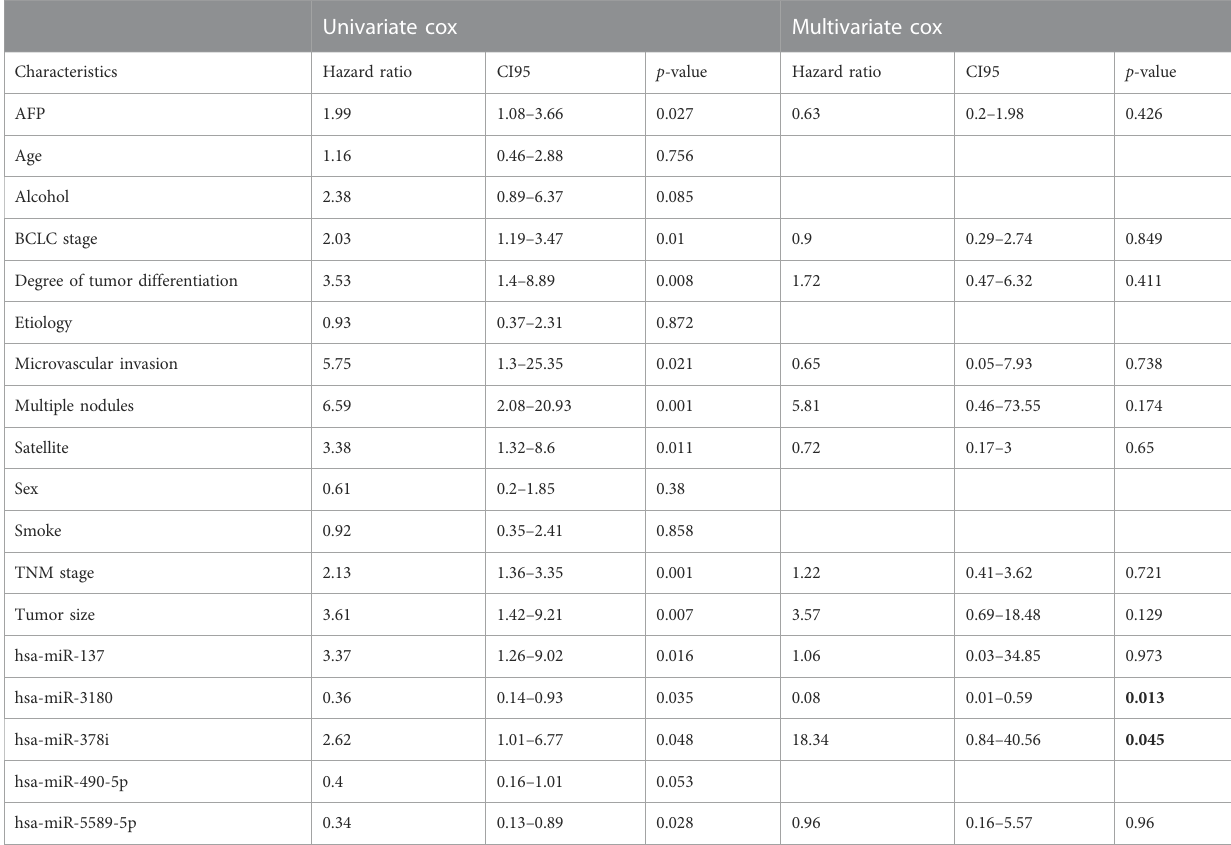
TABLE 1 Univariate and multivariate Cox proportional hazard models for the OS of 32 HCC patients by clinical and demographic factors and